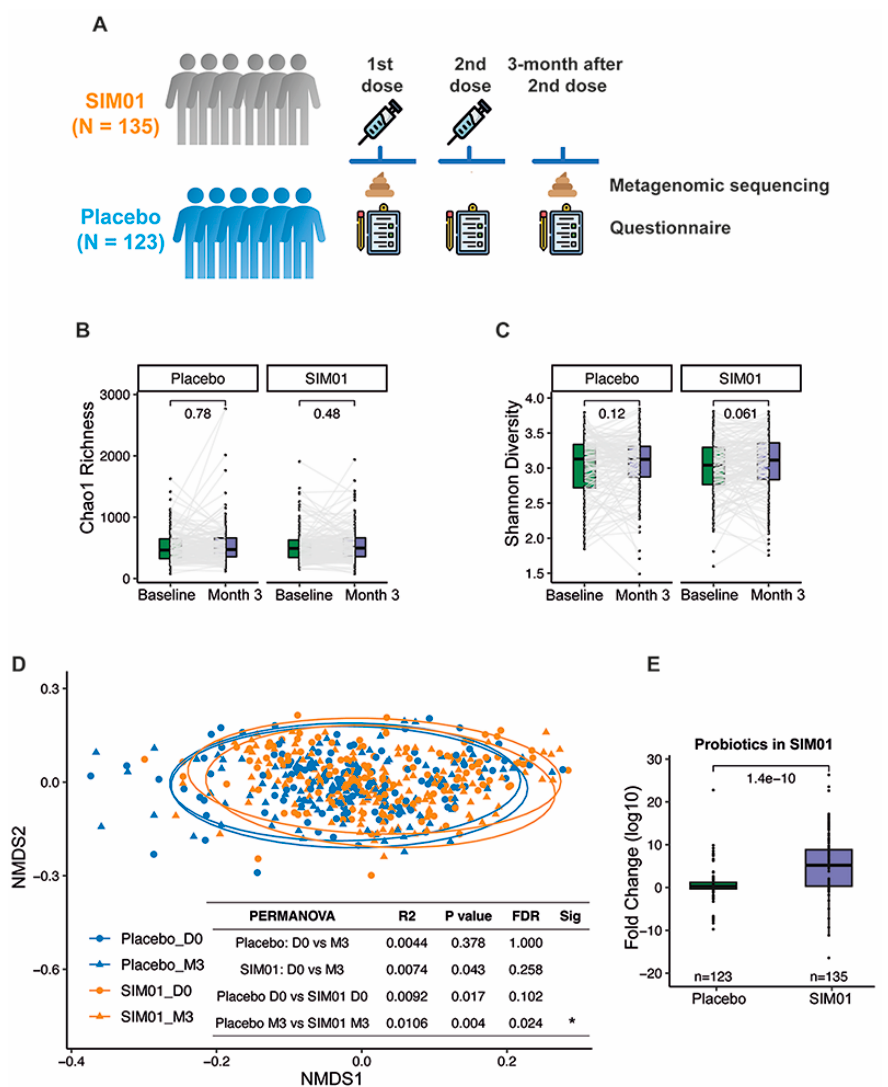
Figure 2. Study design and changes in alpha diversity and beta diversity from baseline to 3 months after the second dose of vaccination. ( A ) Study design. ( B ) Chao1 richness between baseline and 3 months after the second vaccine dose within each group. ( C ) SIM01 oral administration marginally increased the species level-Shannon diversity at 3 months after the second vaccine dose versus the baseline (placebo baseline, n = 123; placebo 3 months, n = 123; SIM01 baseline, n = 135; SIM01 3 months, n = 135). p values were given by paired Wilcoxon rank-sum test (two-sided). Elements on boxplots: centre line, median; box limits, upper and lower quartiles; points, each sample; grey line, the same paired subject. ( D ) Beta diversity was significantly different between placebo and SIM01 groups at month 3 after the 2nd dose of vaccination (placebo baseline, n = 123; placebo 3 months, n = 123; SIM01 baseline, n = 135; SIM01 3 months, n = 135). Pairwise multilevel comparisons were carried out on the JSD distance matrix using a pairwise Adonis test. ( E ) The fold change (month 3/baseline) of three probiotic species in SIM01 was higher in the SIM01 group compared to the placebo group. The p values were given by the Wilcoxon rank-sum test (two-sided); p values were given by PERMANOVA and adjusted for FDR, respectively. FDR, false discovery rate; NMDS, nonmetric multidimensional scaling; PERMANOVA, permutational multivariate analysis of variance; JSD, Jensen-Shannon Divergence (distance); * indicates FDR <